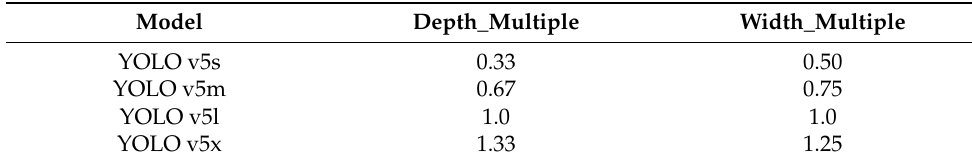
Table 2. Model structure parameter settings.